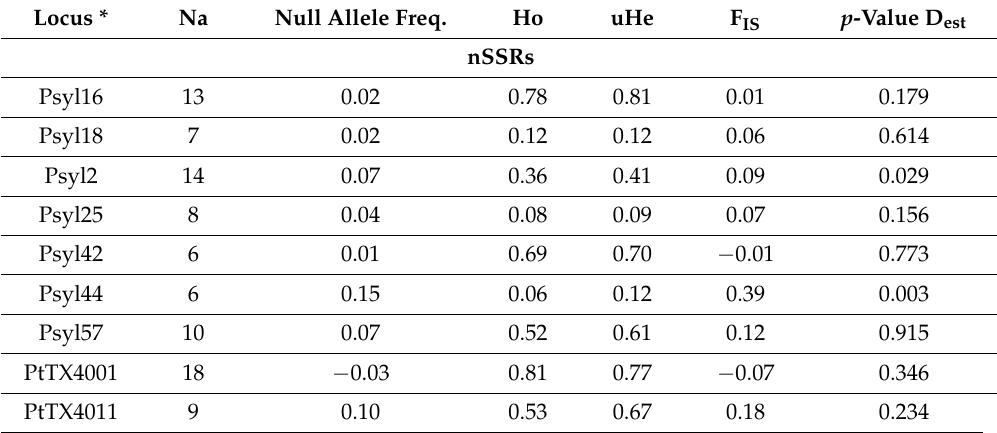
Table 1. The genetic diversity indexes for each locus. p -value Dest is the significance of the Dest values for differentiation among the populations. Sample size 439 trees (nSSRs) and 426 tees cpSSRs. Null allele freq. is the allele frequency by Van Oosterhout et al. [78] (no large allele dropouts detected). Na—number of alleles; Ho—observed heterozygosity; uHe—unbiased genetic diversity; F IS —inbreeding